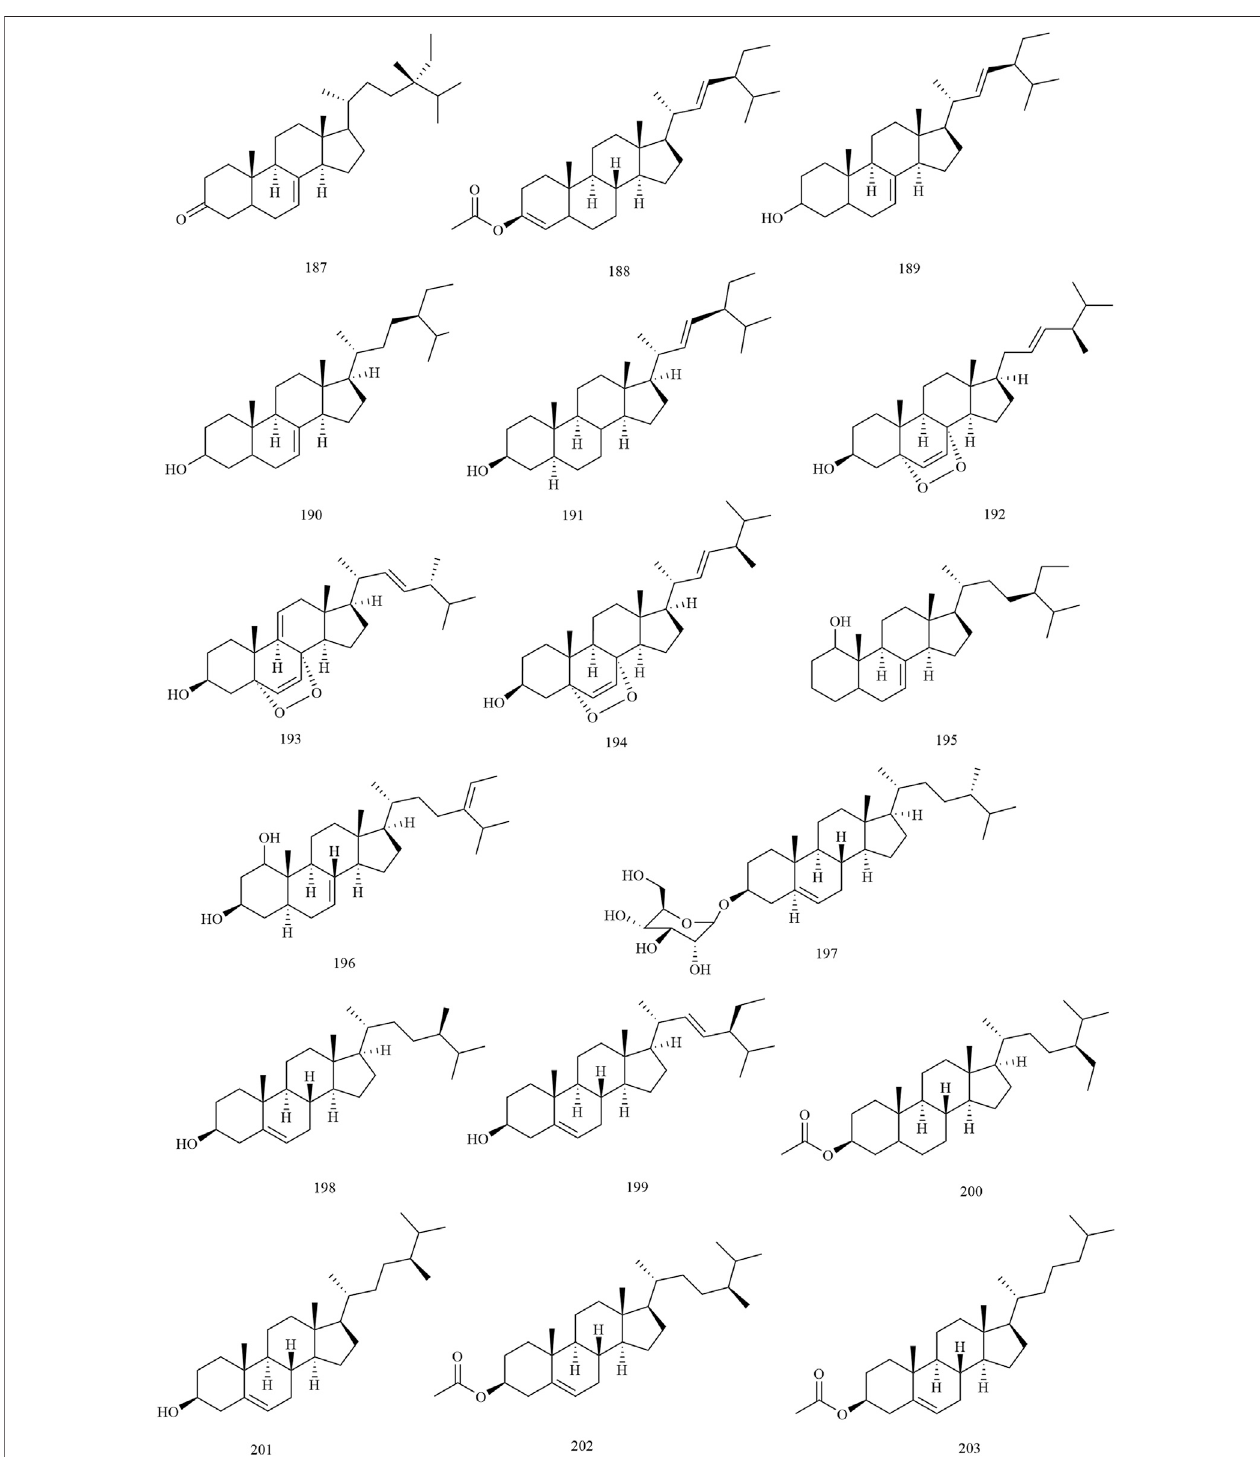
FIGURE 5 | Structures of steroids in X. sorbifolium